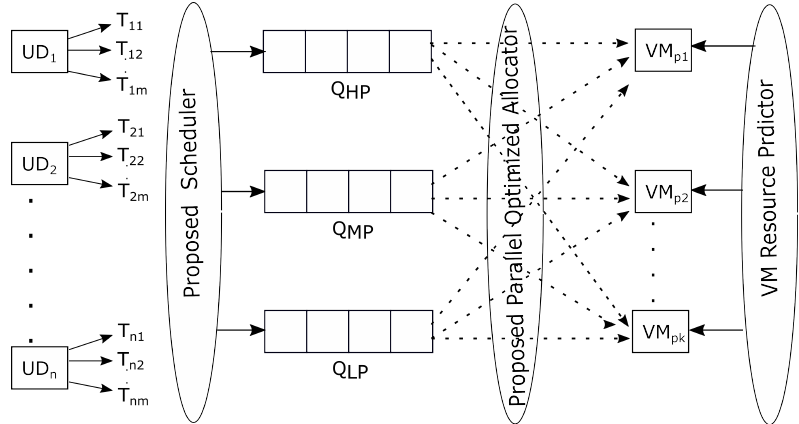
Figure 2. Proposed task-execution